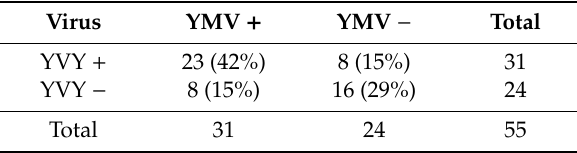
Table 2. Number of yam plants infected by YVY and YMV. Virus YMV +